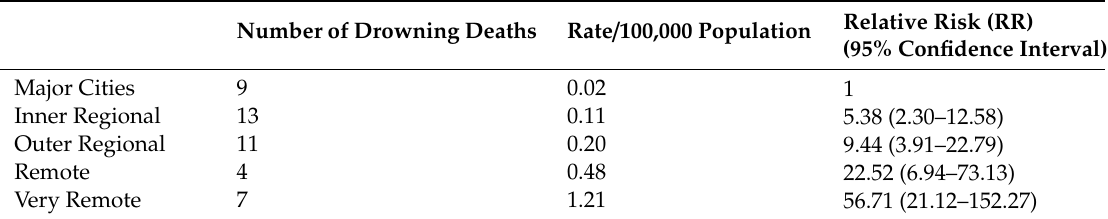
Table 3. Incidents and rates of child and adolescent flood-related drowning per 100,000 population by remoteness classification, Australia, 2002 / 03–2017 / 18 (N = 44). Number of Drowning Deaths Rate / 100,000